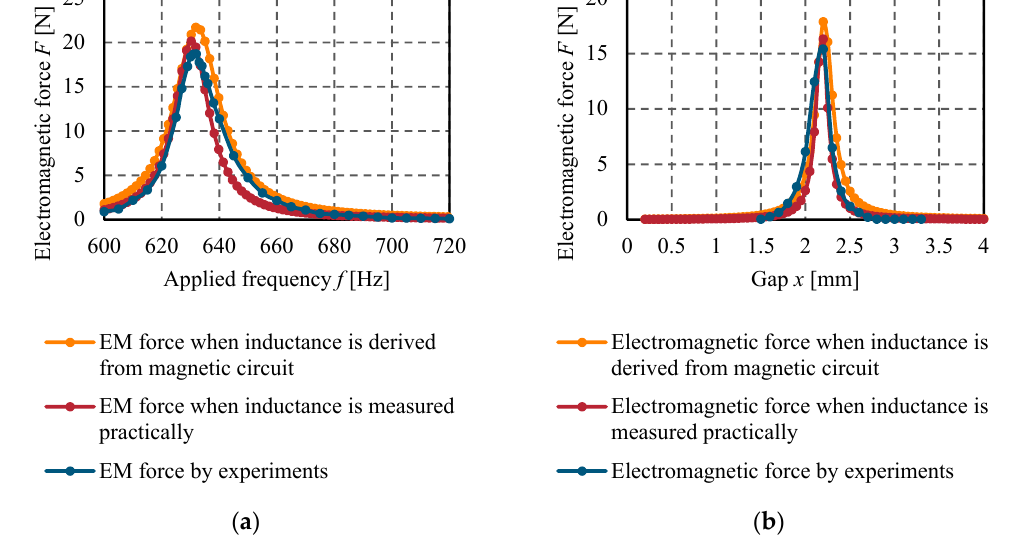
Figure 13. The comparison of the characteristics curve of electromagnetic attractive force: ( a ) when the gap x is 2.0 mm; ( b ) when the applied frequency f is 650 Hz.